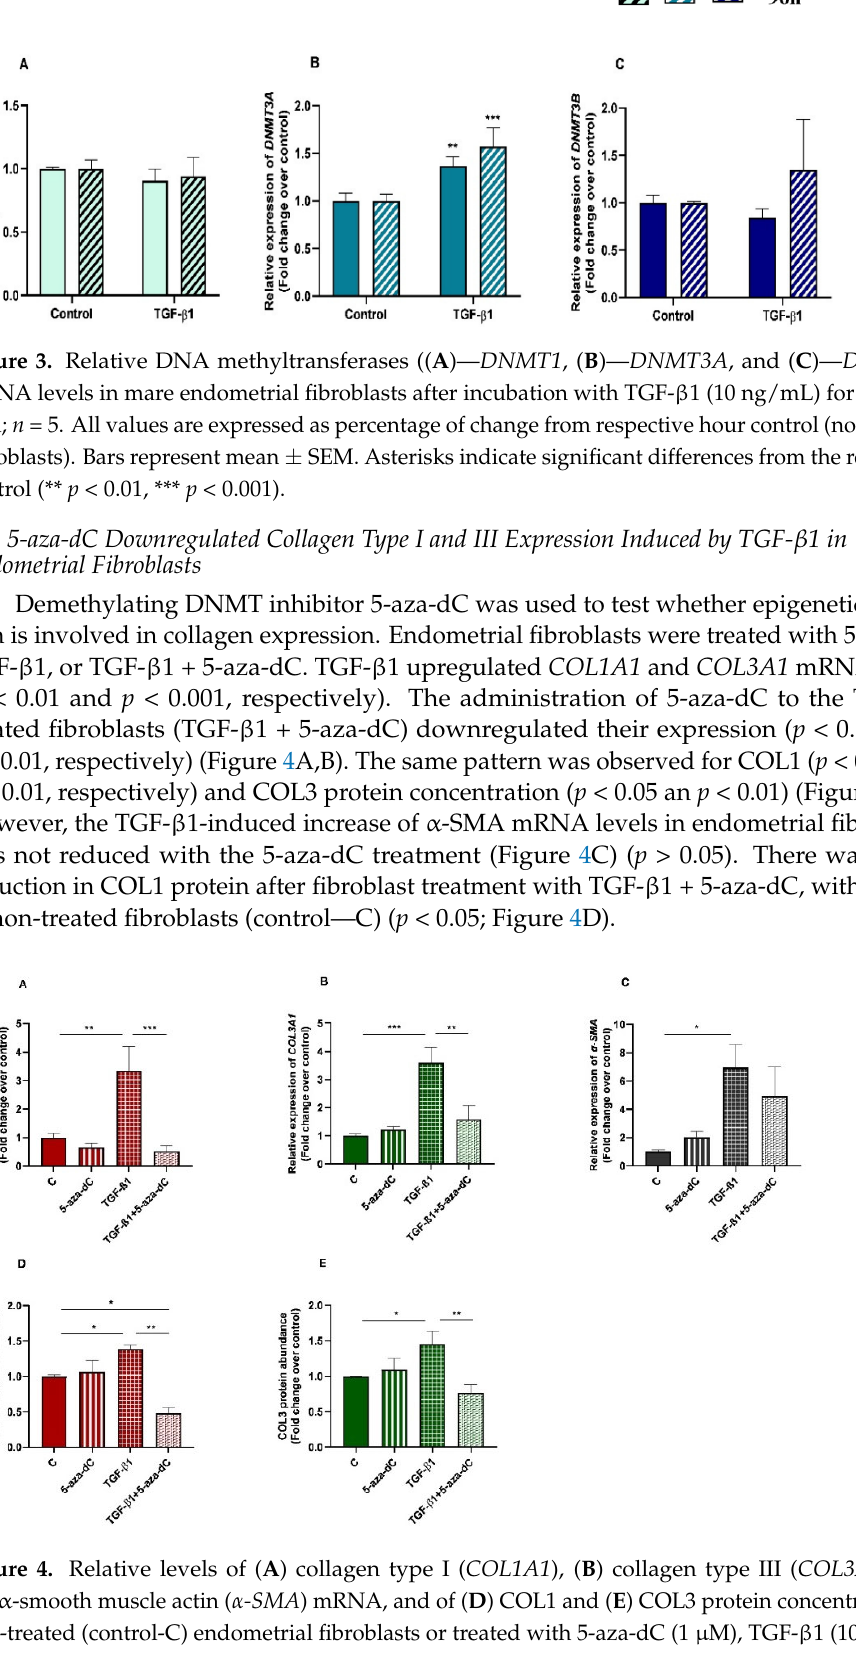
Figure 4. Relative levels of ( A ) collagen type I ( COL1A1 ), ( B ) collagen type III ( COL3A1 ), and ( C ) α -smooth muscle actin ( α -SMA ) mRNA, and of ( D ) COL1 and ( E ) COL3 protein concentrations in non-treated (control-C) endometrial fibroblasts or treated with 5-aza-dC (1 µ M), TGF- β 1 (10